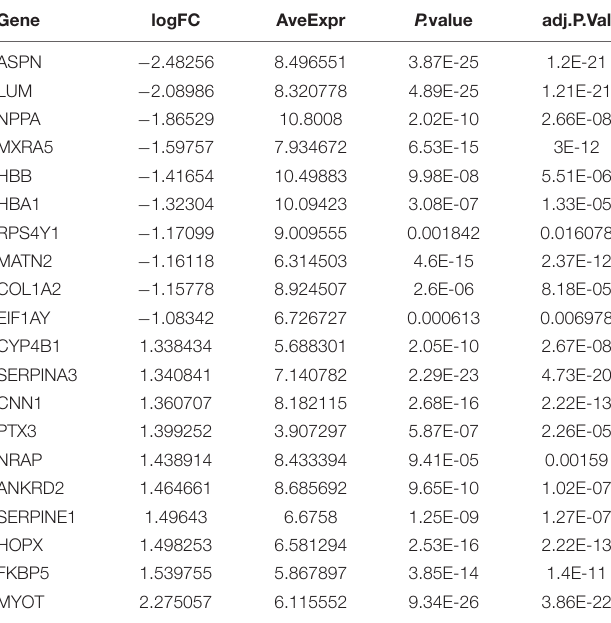
TABLE 1 | Top 10 upregulated and downregulated genes between MI and non-failing controls are listed. Gene logFC AveExpr P. value